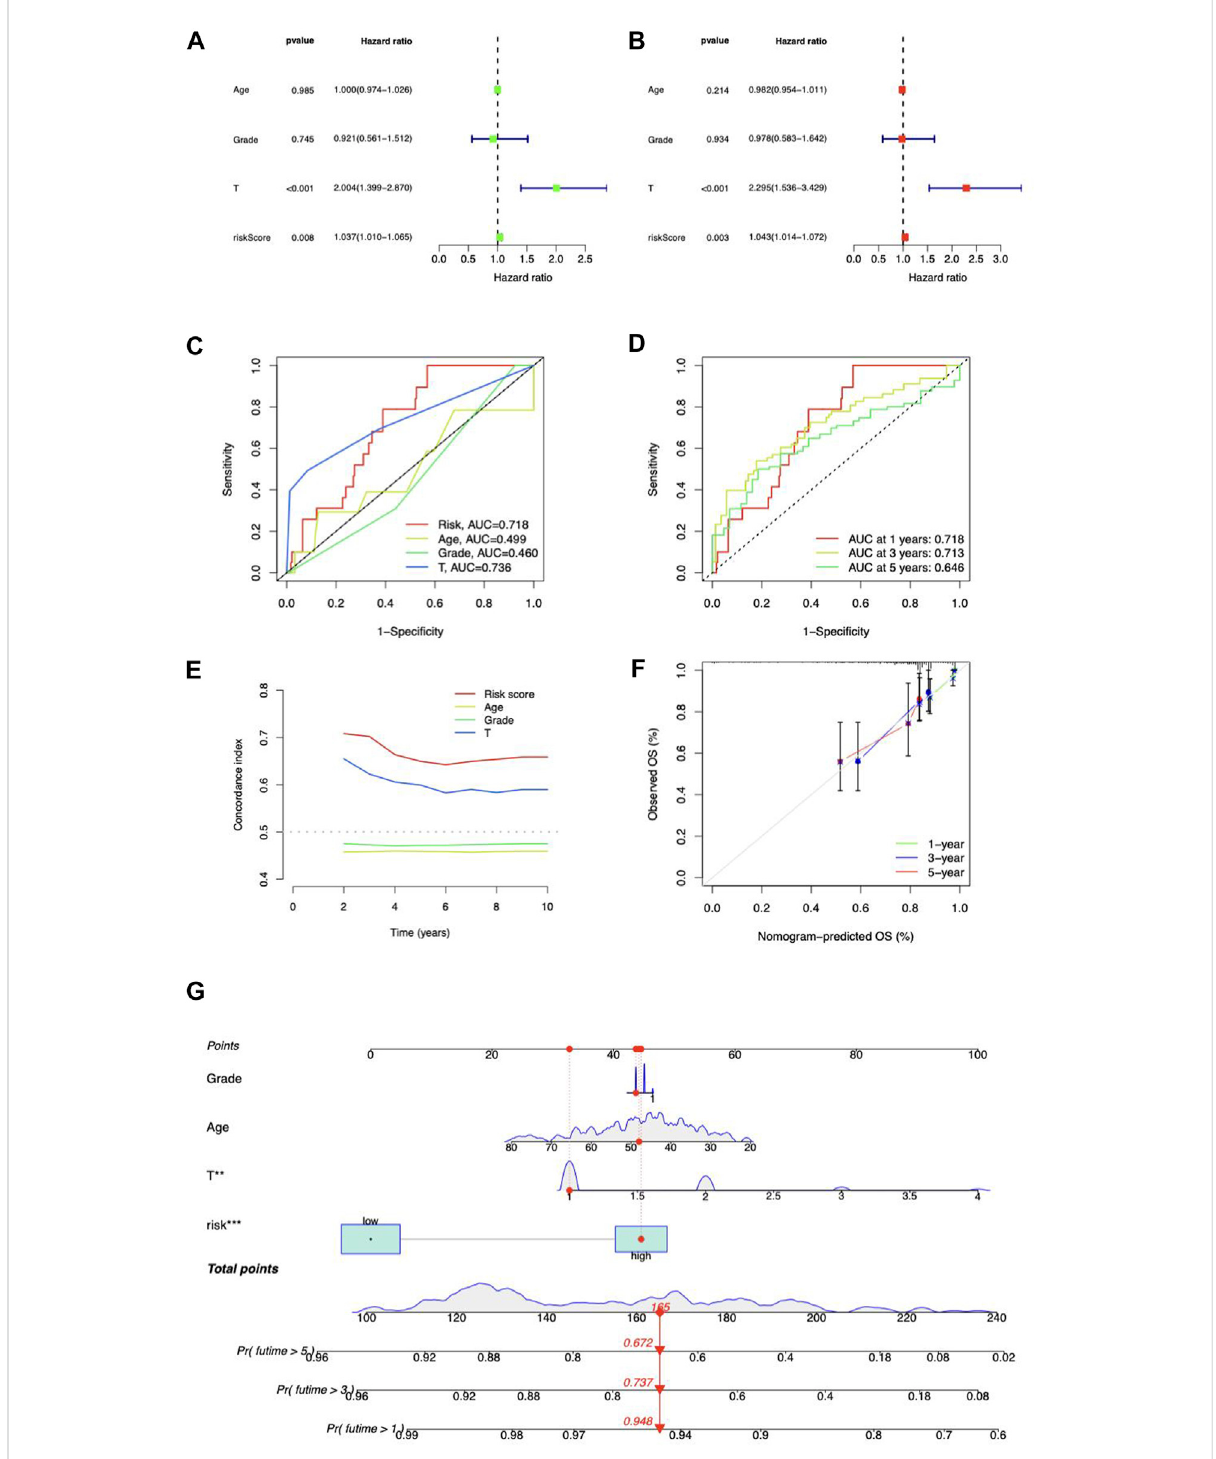
FIGURE 5 Prognosis value of risk model. (A) Univariate and (B) multivariate Cox regression of the independent analysis for prognosis. (C) Predictive accuracy of the risk model compared with age, Grade, and T stage. (D) Time-dependent ROC curve prediction. (E) C-index curve analysis. (F) Calibration curves in predicting outcomes at 1, 3, and 5 years. (G) Nomogram of risk score and clinicopathological variables and predicts 1-, 3-, and 5-year OS in